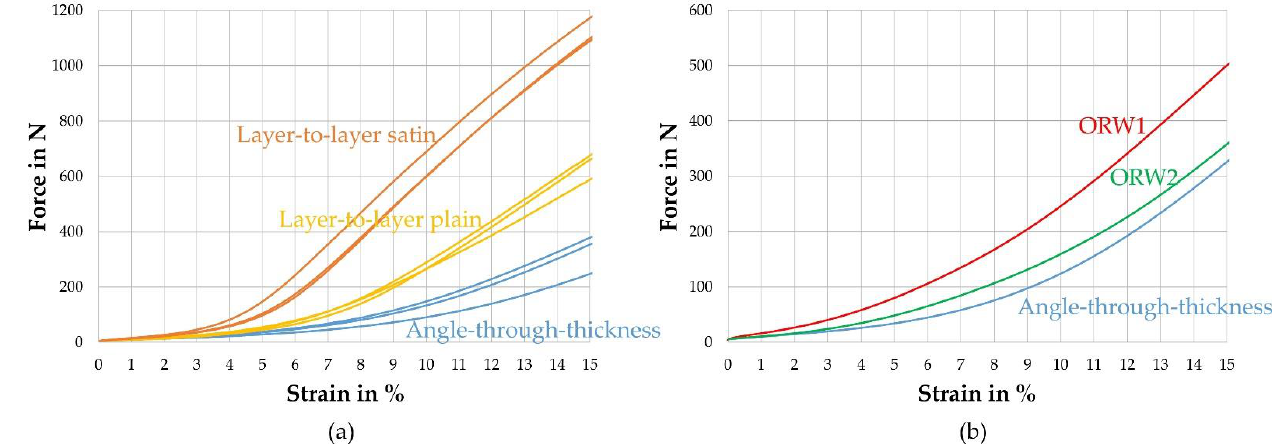
Figure 6. Force-strain behavior in the range up to 15% elongation of ( a ) multilayer weaves and ( b ) ORW weaves (mean) as measured from tensile